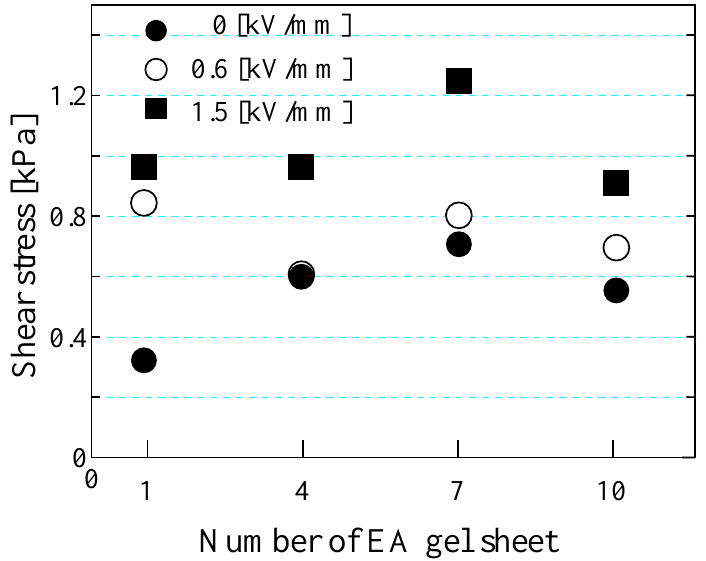
Figure 13. Shear stress with up to 10